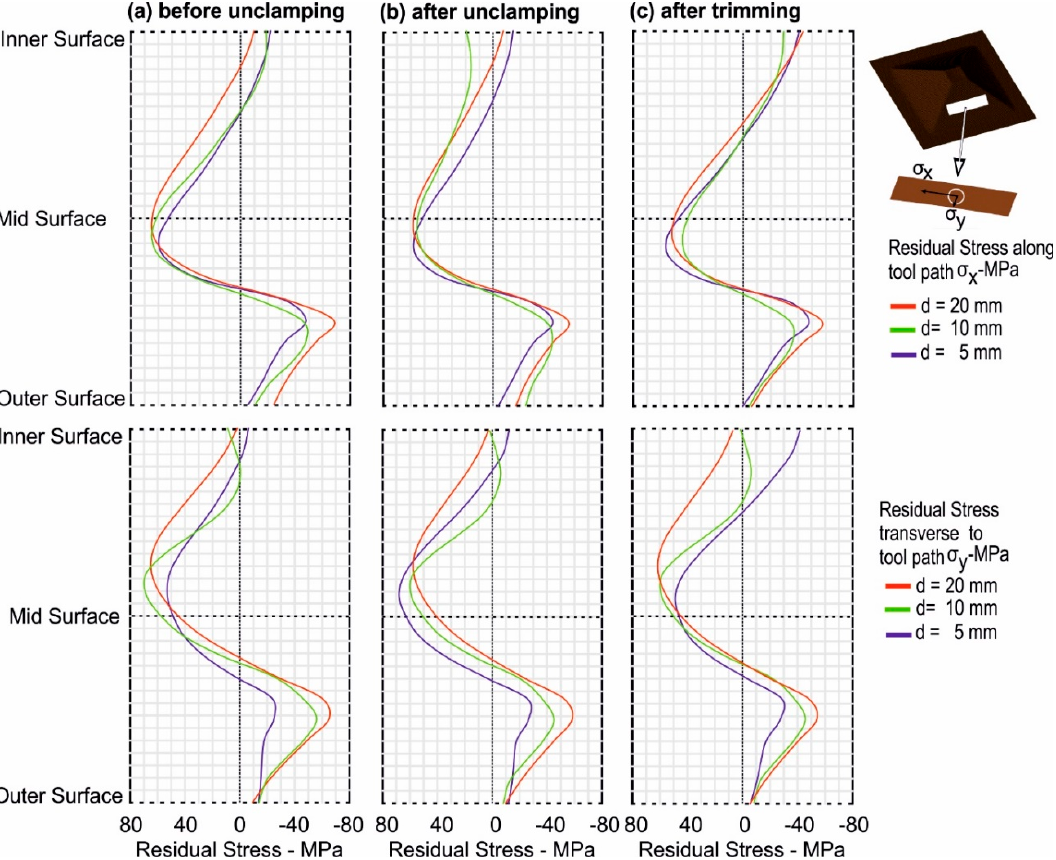
Figure 11. Distribution of the residual stresses in the center of the strip along and in the transverse direction of the tool motion for different tool diameters: ( a ) before unclamping, ( b ) after unclamping, and ( c ) after trimming.